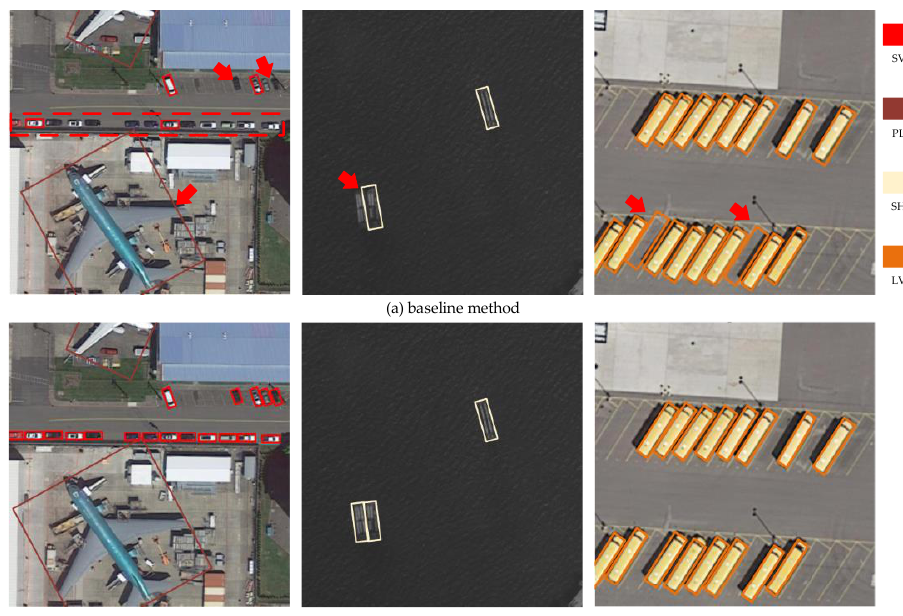
Figure 9. Comparison of detection results.